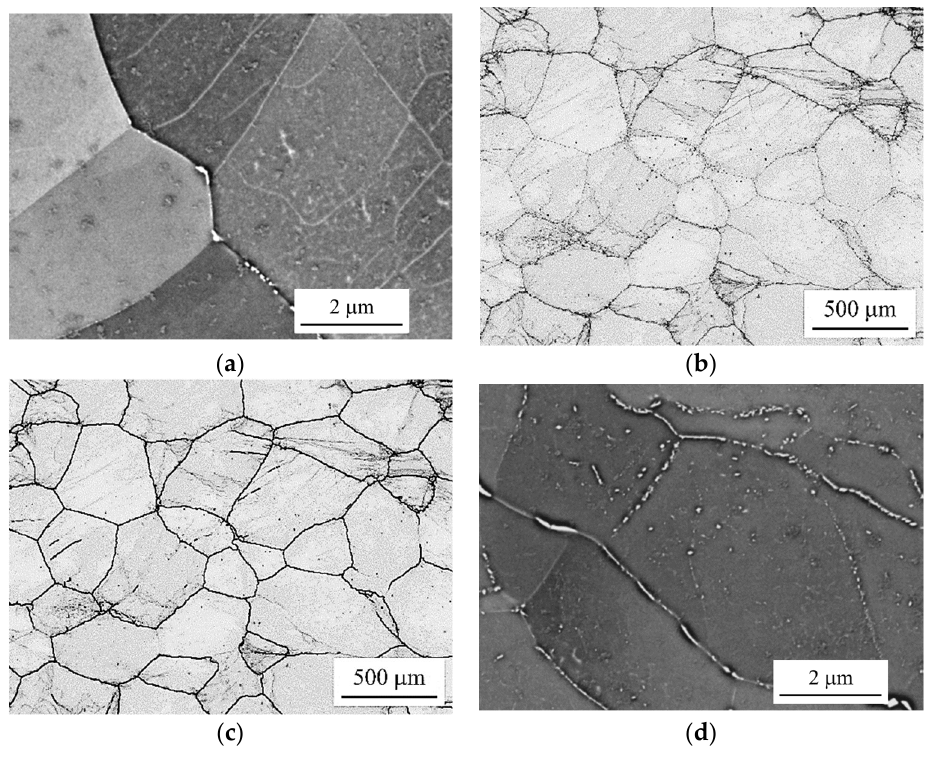
Figure 3. Micrographs of as ‐ rolled HiperFer steels. ( a ) Scanning electron image typical for 17Cr1_1 and 17Cr1_2). ( b ) Electron backscatter diffraction band contrast image of 17Cr2_4 steel. ( c ) Band contrast image with high ‐ angle grain boundaries indicated in black to distinguish them from the sub ‐ grain structure. ( d ) Electron micrograph of as ‐ rolled 17Cr1_3 steel.